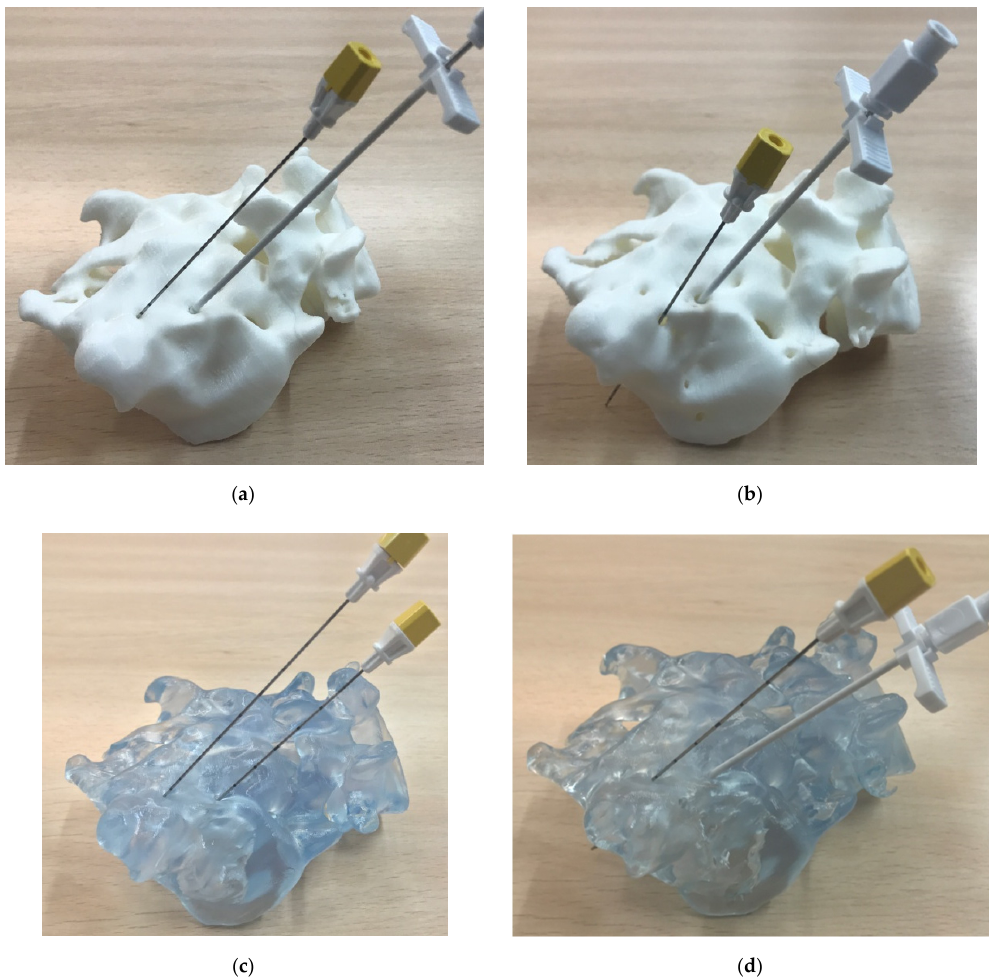
Figure 5. Surgical planning using the generated models: Geometrical differences and validation of the most adequate segmentation and technique for these interventions: ( a , b ) FDM prototypes. ( c , d ) Laser stereolithography prototypes. ( a – c ) Segmentation A. ( c , d ) Segmentation B. The denser